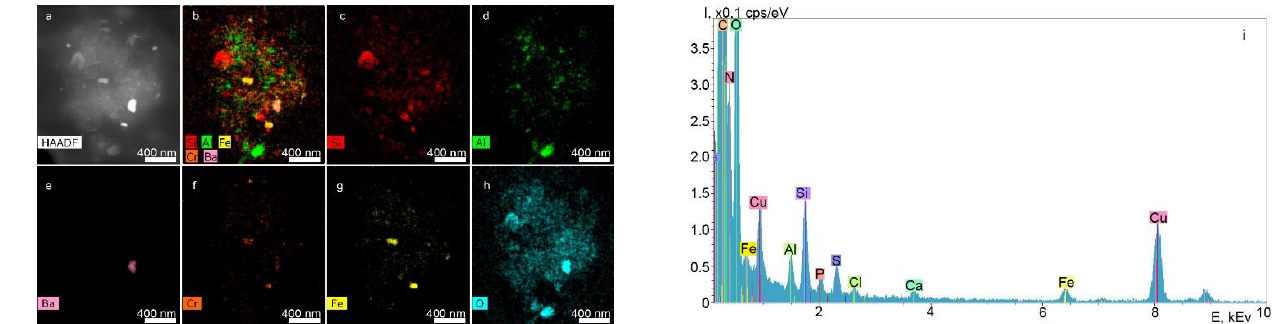
Figure 5. STEM image of particles with z-contrast ( a ), chemical element distribution maps ( b – h ) and the corresponding energy-dispersive spectrum ( i ).